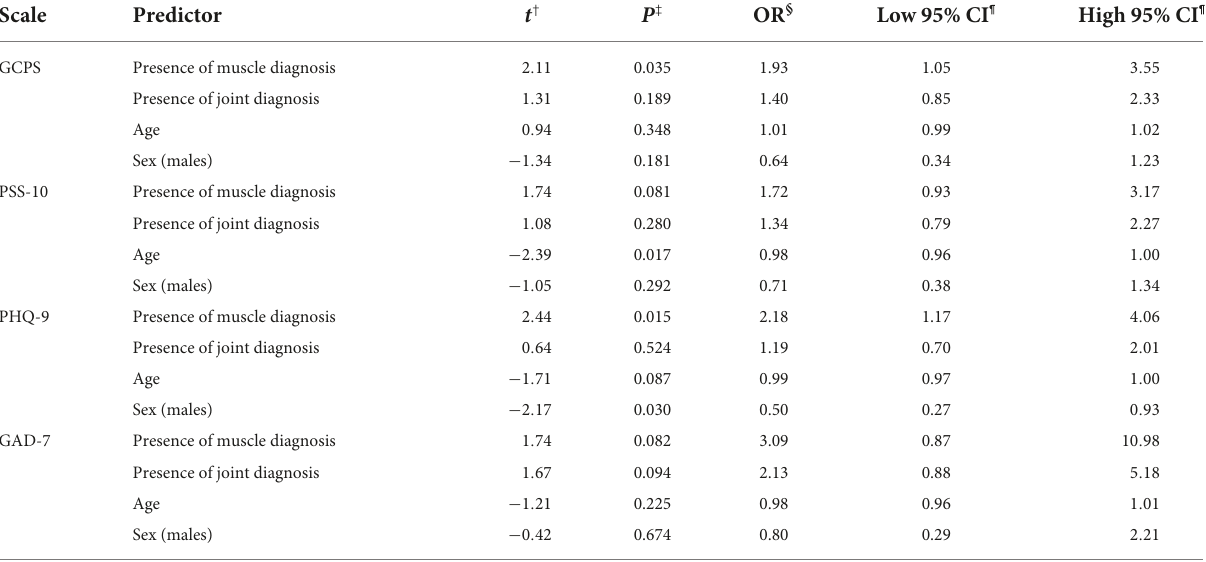
TABLE 5 The results of multiple ordered logistic regression of the graded total scores of the GCPS, PSS-10, and PHQ-9 on the presence of muscle diagnosis, the presence of joint diagnosis, age, and sex. Scale